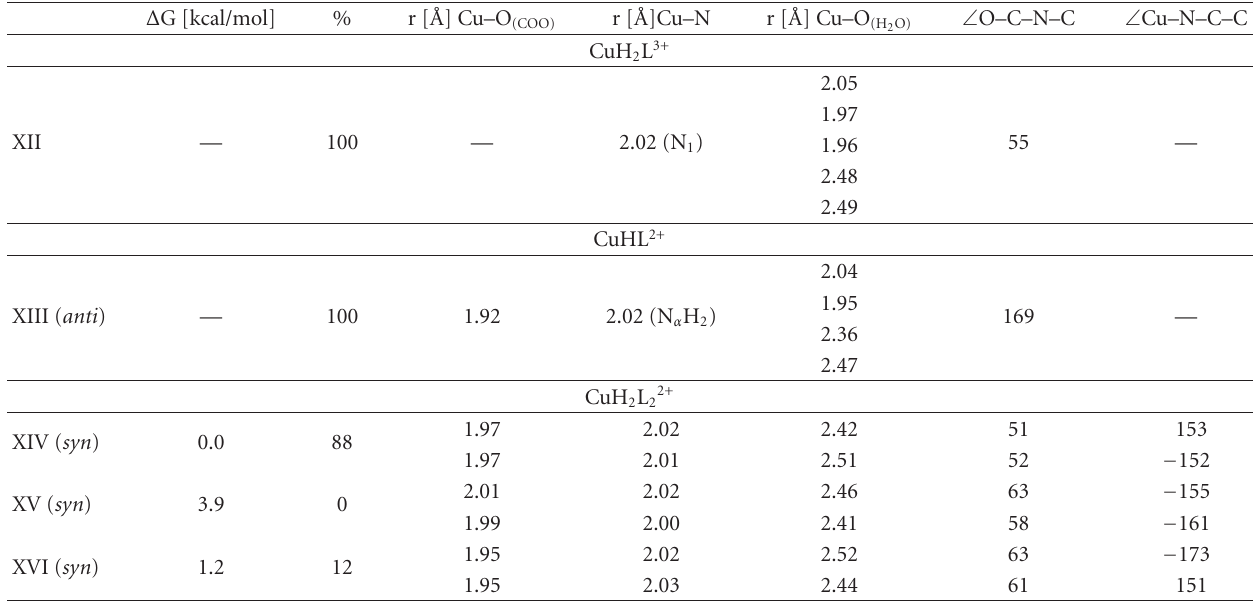
Table 3: Relative Gibbs free energies, Boltzmann factors (in percent), and selected geometrical parameters for Cu(II)-SFG complexes. Δ G